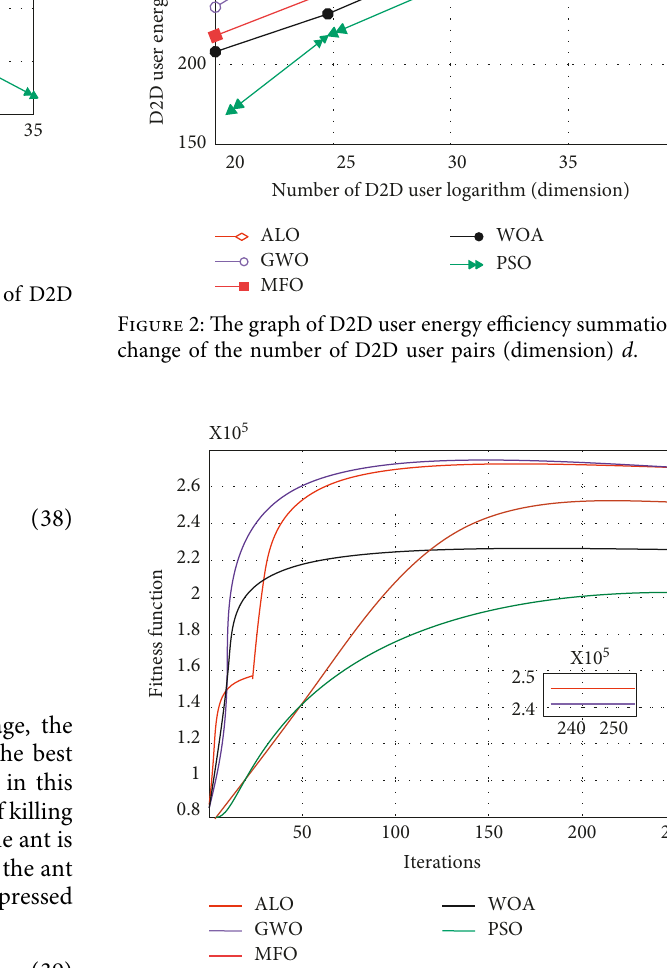
Figure 3: Convergence